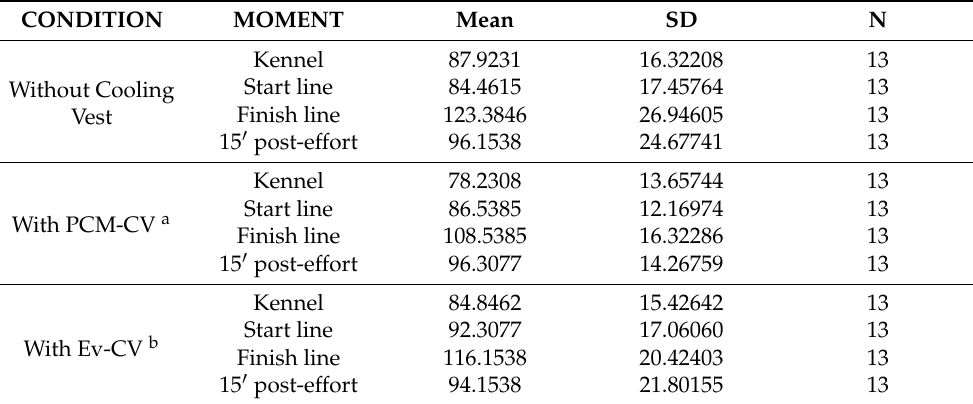
Table 11. Mean values and standard deviations for the pulse rate. CONDITION